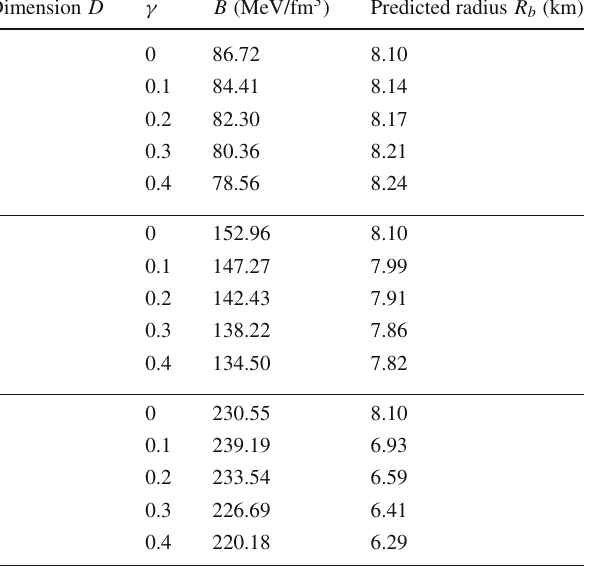
Table 5 Predictedradius of HER X-1 having mass M = 0.85 M (cid:2) . Here the bag parameter ( B ) is defined at the surface of the compact object where radial pressure vanishes. The pressure anisotropy parameter ( α ) is taken as unity Dimension D